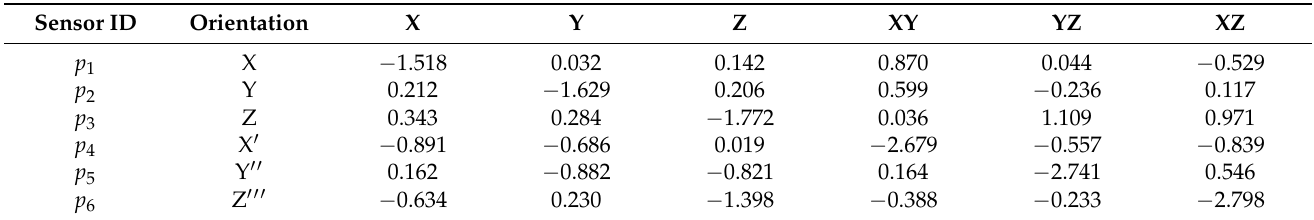
Table 1. Sensitivity coefficients: ratio between each sensor output (positive in compression) and nominal load (positive in traction) for the six tested load conditions.